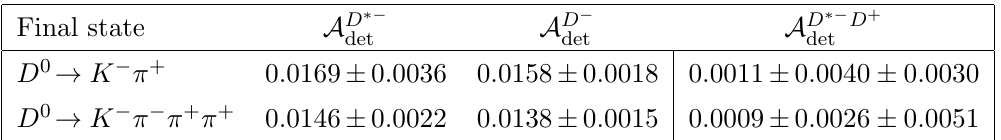
D (cid:3)(cid:6) D (cid:7) decays !